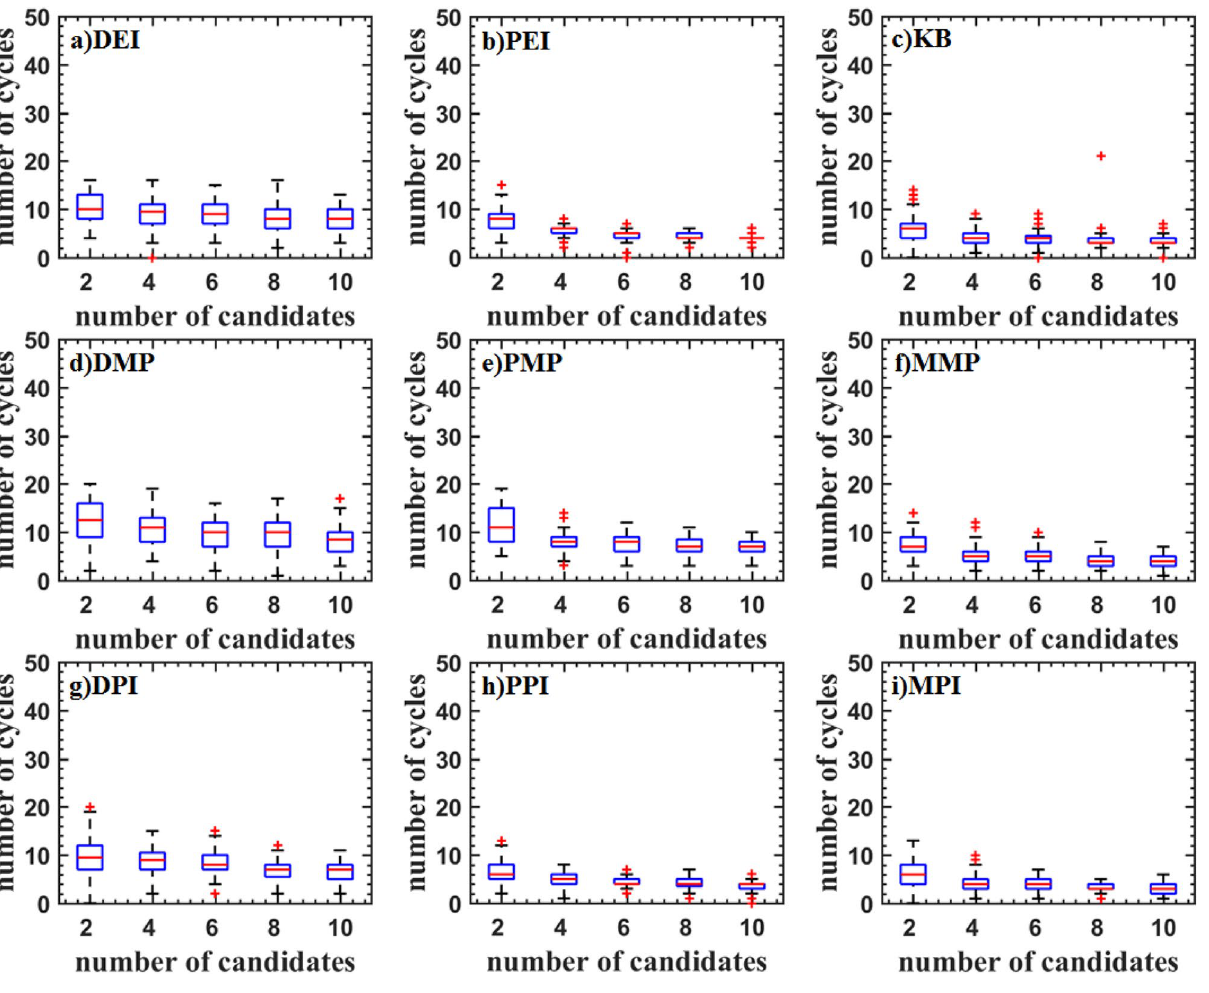
Figure 7. Test problems: Hartman3